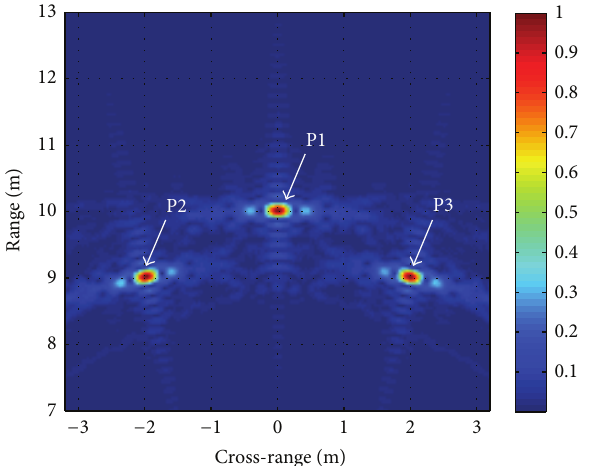
Figure 11: The original imaging result by the back projection imaging method.